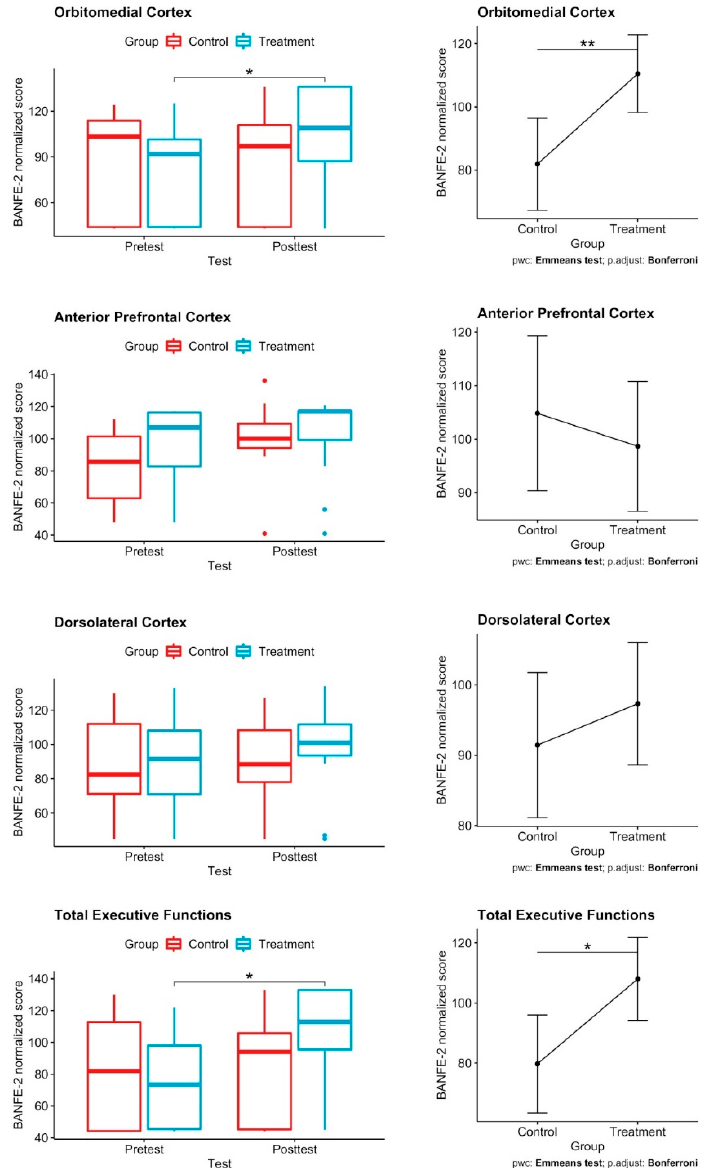
Figure 3. Effect of LEGO ® -based therapy in pediatric patients with congenital heart disease. Left : Box plots depict changes in BANFE-2 scores of congenital heart disease pediatric patients in the control and treatment groups; there was a significant score increase after LEGO ® -based therapy in the orbitomedial cortex and in the total executive functions. ANCOVA test; * p ≤ 0.050, ** p < 0.01. Right : ANCOVA followed by Bonferroni post hoc test applying multiple testing correction; there is an increase in the adjusted mean score in the LEGO ® -based therapy group in all evaluated areas, with the exception of the anterior prefrontal cortex. Control n = 10; treatment n = 14.